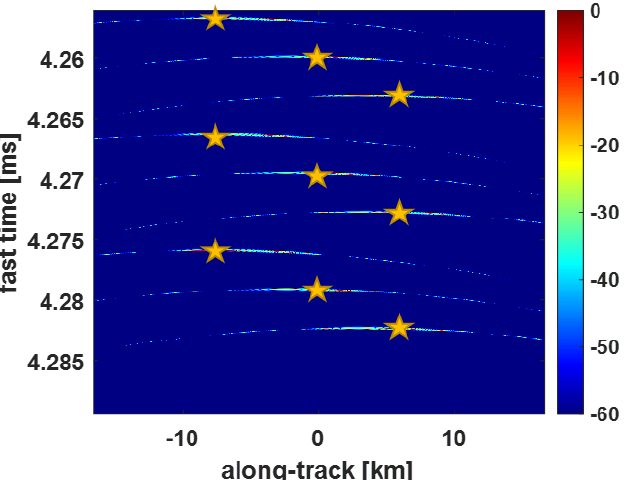
Figure 9. Amplitude of the simulated RGC point target dataset. The stars mark the zero Doppler positions of the targets.